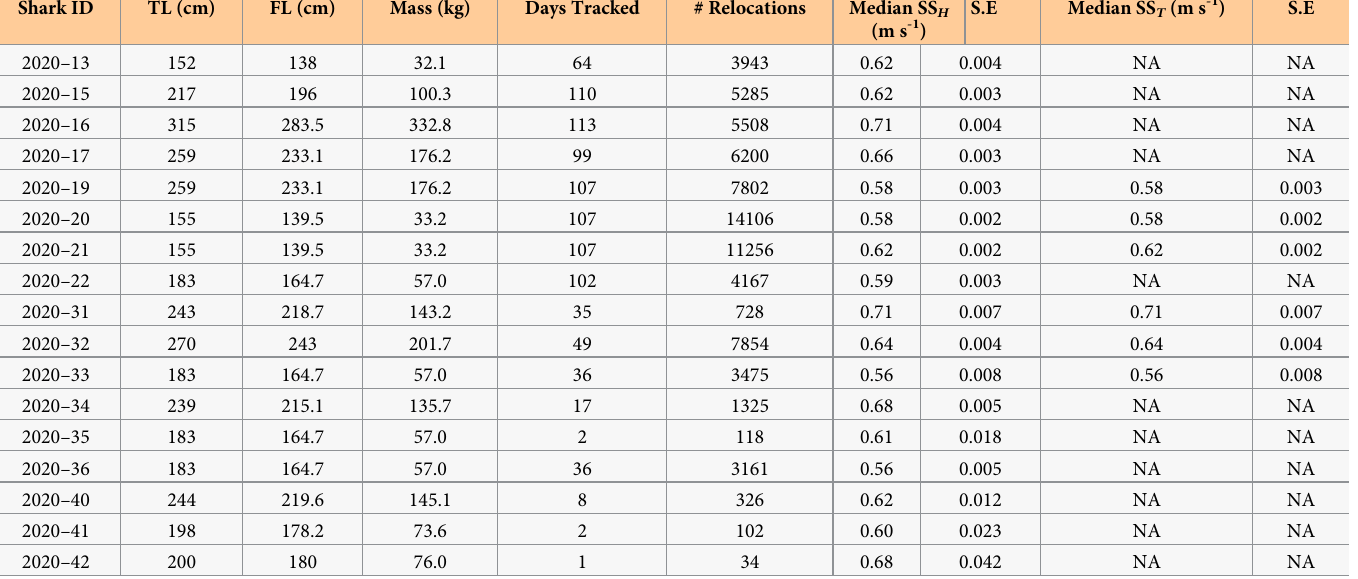
Table 1. Details of VPS derived cruise speed data for all juvenile white sharks. Shark ID TL